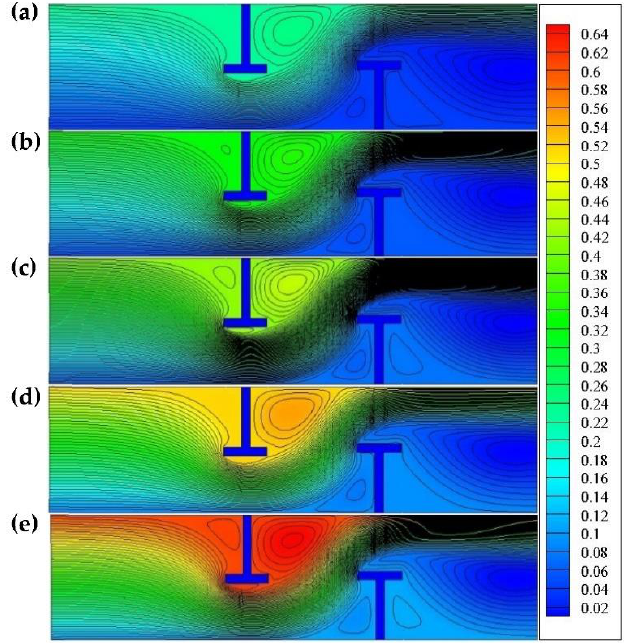
Figure 4. Flow patterns for: Re = ( a ) 12,000; ( b ) 17,000; ( c ) 22,000; ( d ) 27,000; ( e ) 32,000.